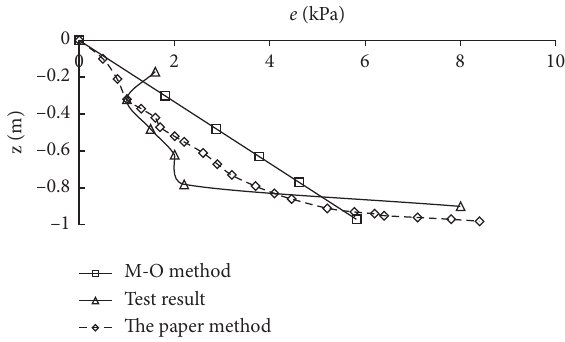
Figure 6: Comparison of calculation results and test results.